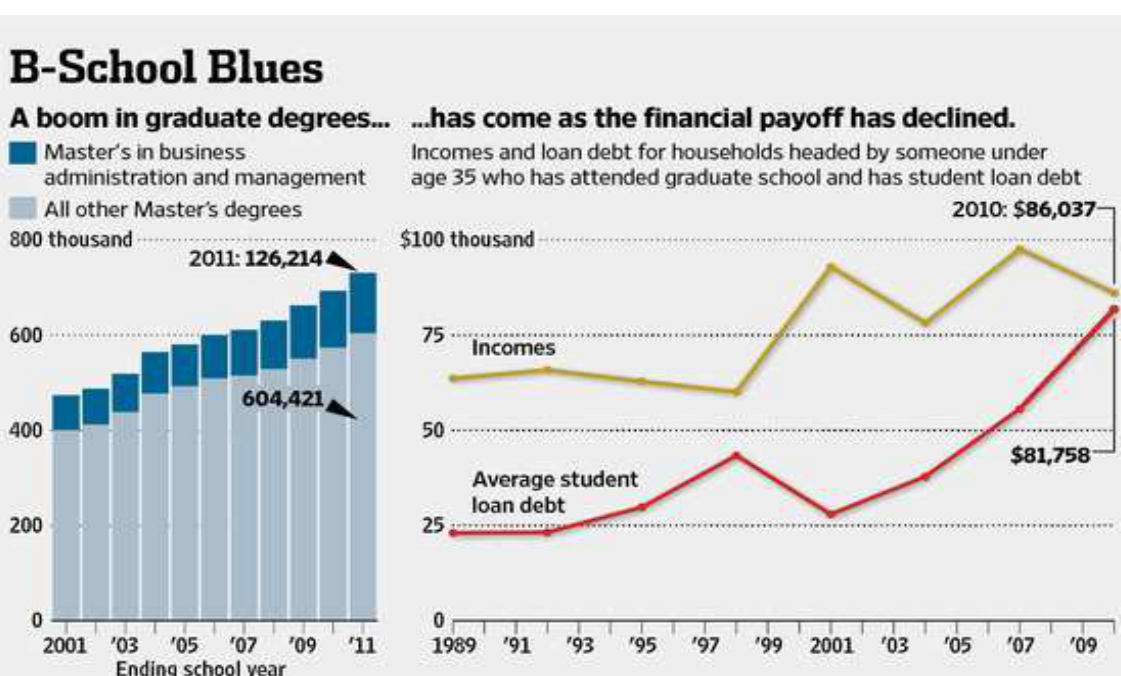
Figure 1. More graduates, lower